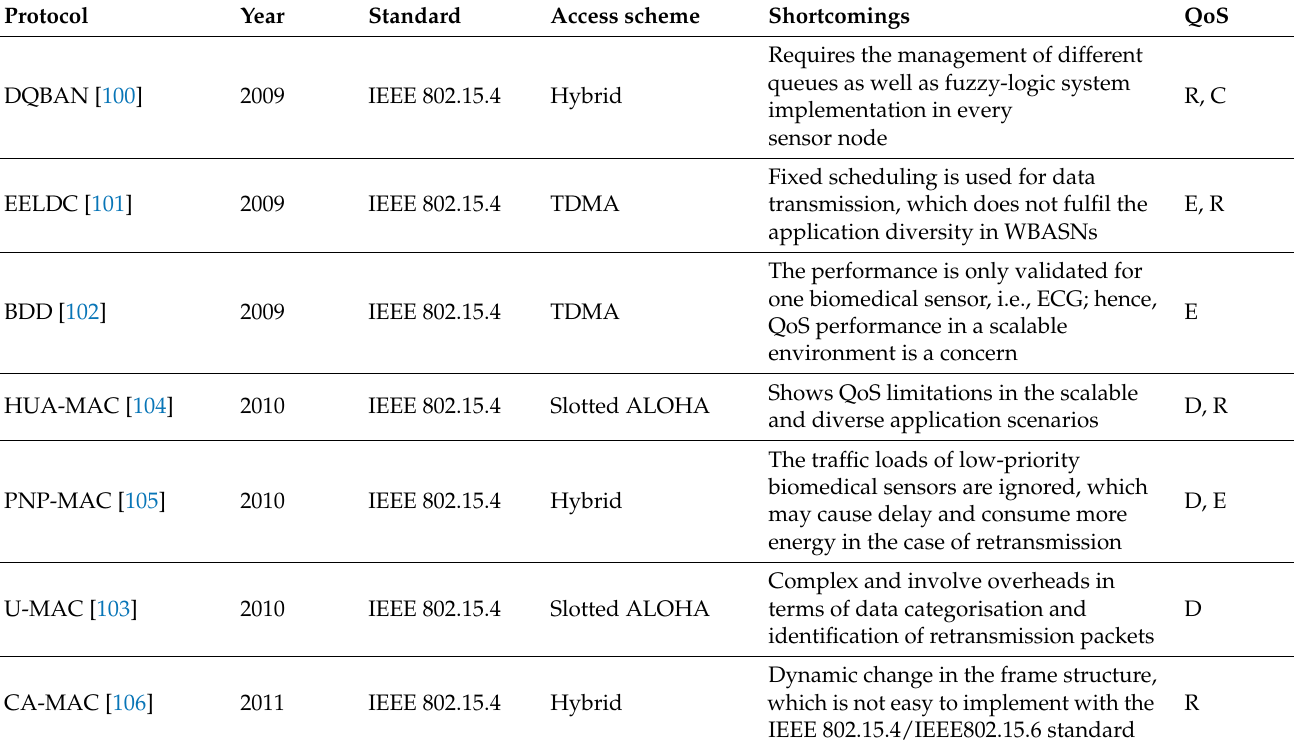
Table 8. Comparison of WBASN MAC